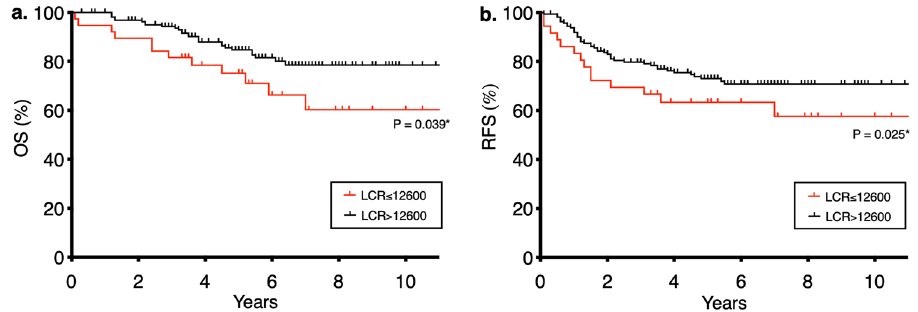
Figure 2. Comparison of ( a ) Overall survival (OS) and ( b ) recurrence-free survival (RFS) between high LCR and low LCR groups. LCR lymphocyte count/C-reactive protein